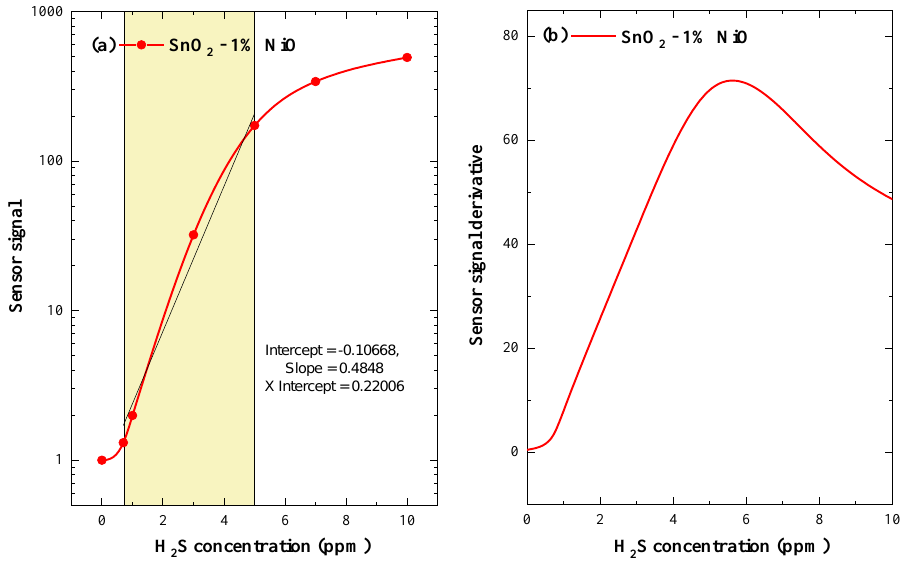
Figure 11. Sensor signal of SnO 2 -1%NiO operated at 200 °C under 50% RH with respect to the H 2 S concentration ( a ) and the first derivative of the sensor signal versus H 2 S concentrations ( b ).